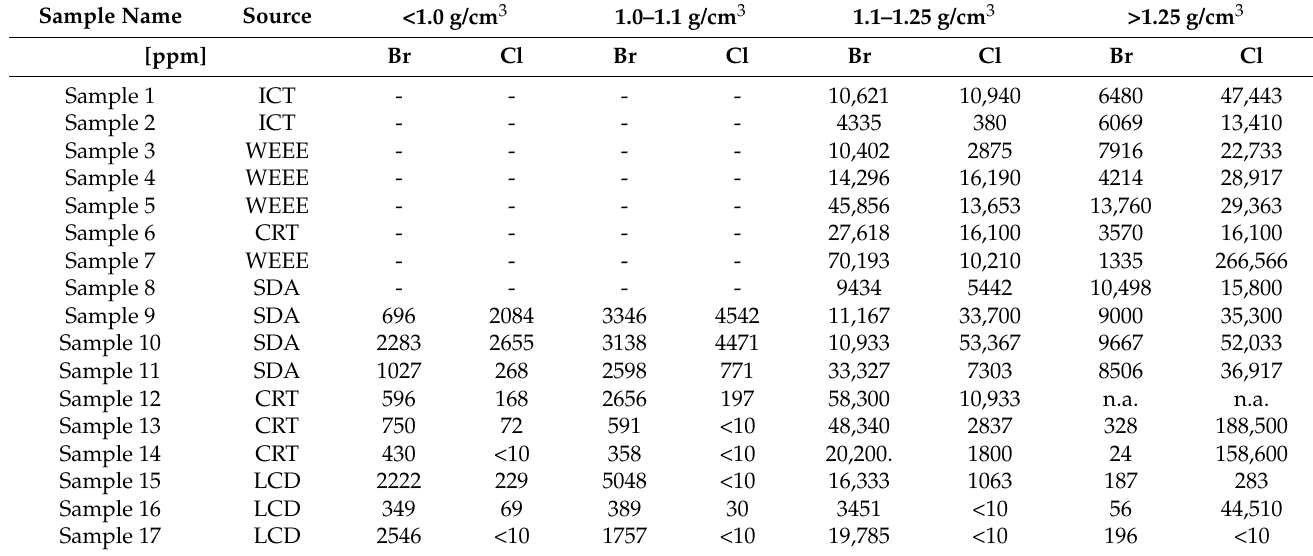
Table 3. Overview of the bromine and chlorine content in mg/kg (ppm) of the different samples.